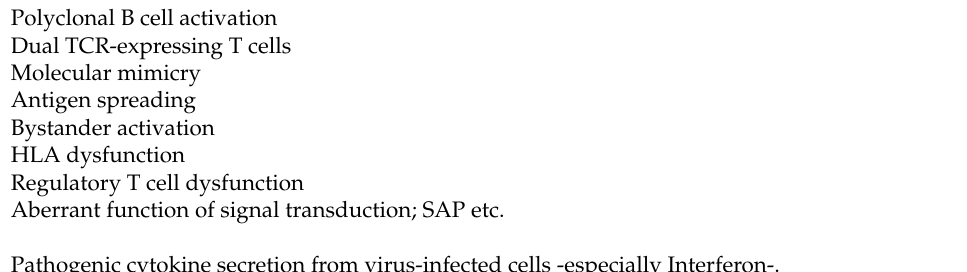
Table 3. Autoimmune processes with possible roles of viral